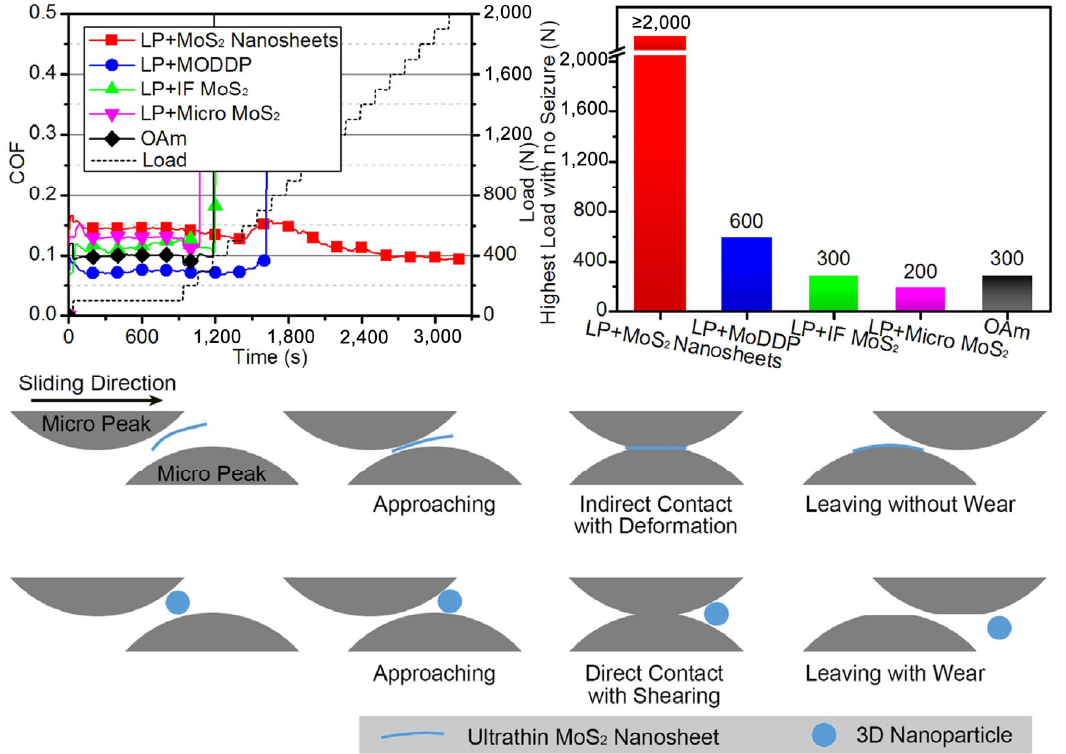
Fig. 4 Results of the load-climbing tribological tests and schematic of the lubrication mechanism of 2D nanosheets and 3D nanoparticles. Reproduced with permission from Ref. [55], © Springer Nature